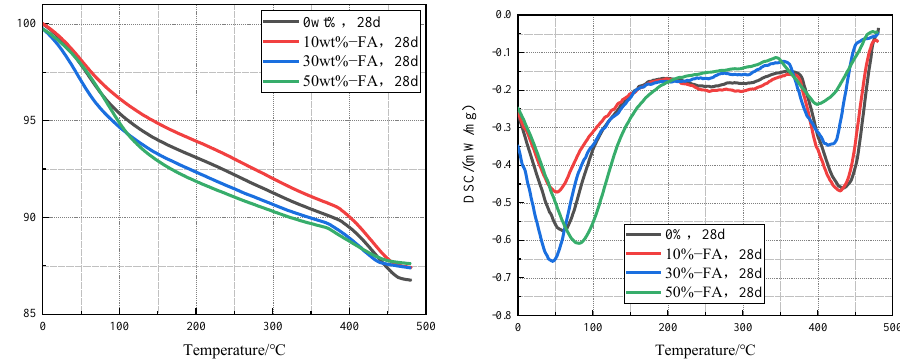
Figure 7. TG-DSC curves of cement pastes containing 0%, 10%, 30%, and 50% fly ash after curing at 20 °C for 28 days.